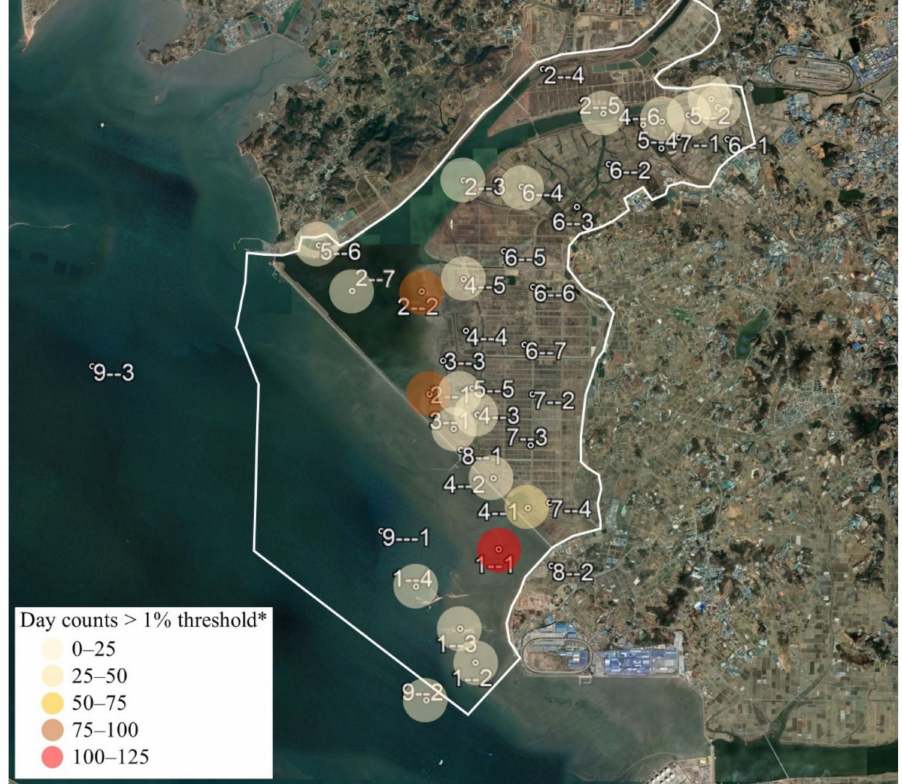
Figure 2. Survey sub-units, and the location by sub-unit of internationally important concentrations of waterbirds as recorded by our surveys between June 2020 and May 2021. The outer boundary of the Hwaseong Wetlands FNS, revised in early 2021, is outlined in white. The first of the two numbers in each of the 39 sub-units within and in two of the subunits outside of the FNS, identifies the main habitat type. Sub-units starting with “1” = open tidal flat outside of the sea-dyke; “2” = “wet”